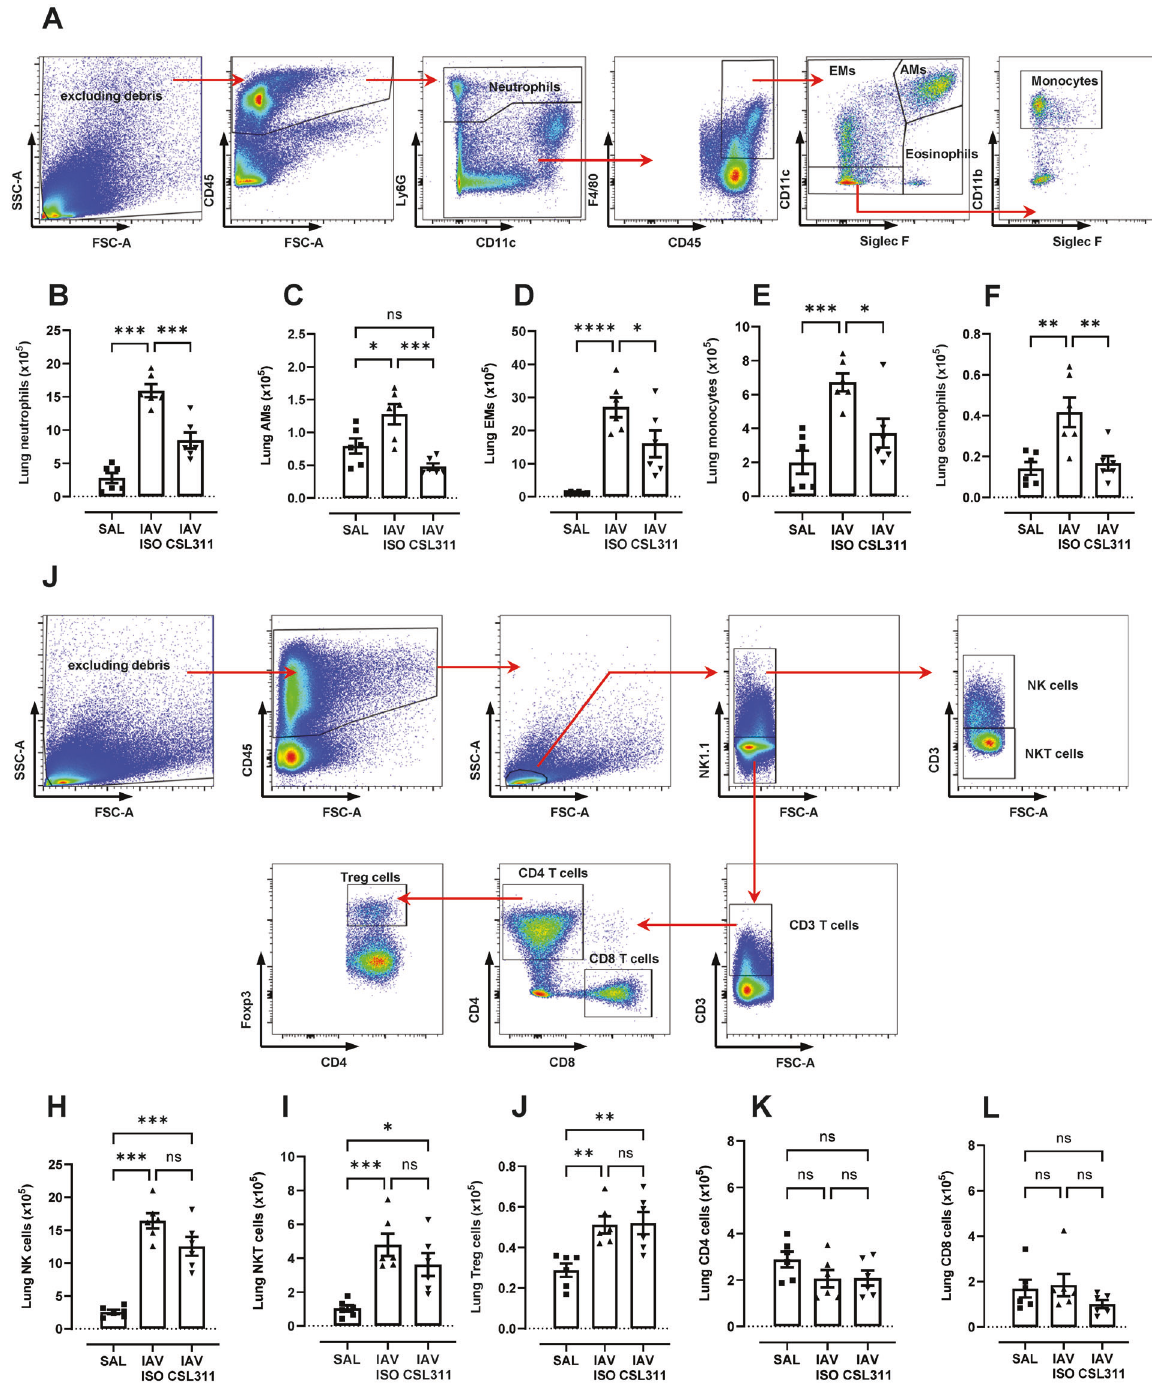
Fig. 7 CSL311 blocks lung myeloid cells and preserves NK cell and T cells in IAV-infected h β c Tg mice. Flow cytometry analysis utilizing a ( A ) gating strategy for myeloid cells revealed that lung ( B ) neutrophils, ( C ) alveolar macrophages (AMs), ( D ) exudative macrophages (EMs), ( E ) monocytes and ( F ) eosinophils were highly increased in h β cTg mice at day 6 post IAV infection, and signi fi cantly reduced with CSL311 treatment. Flow cytometry analysis utilizing a ( G ) gating strategy for delineating lymphoid cells demonstrated that lung ( H ) NK cells, ( I ) NKT cells and ( J ) regulatory T cells (Tregs) were increased following IAV infection and were not affected by CSL311 treatment. K Lung CD4 cells and ( L ) CD8 cell numbers in the lungs did not differ across all groups; n = 6; data are Mean ± SE; * p < 0.05, ** p < 0.01, *** p < 0.001 one- way